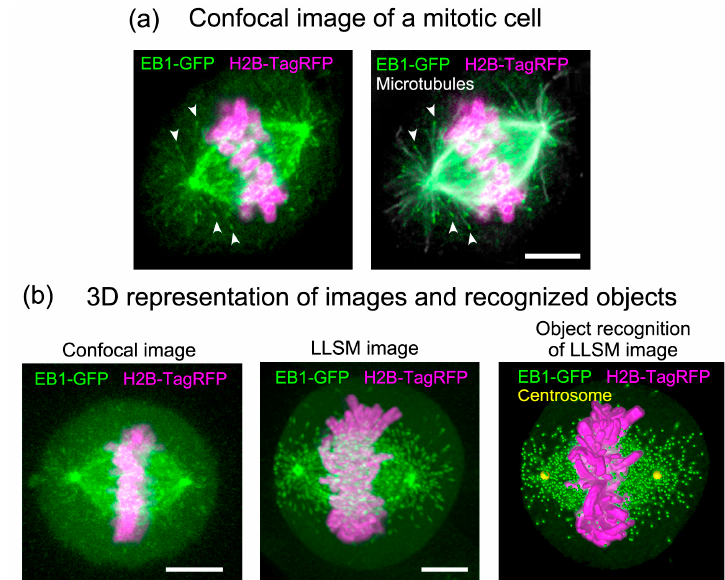
Figure 3. Comparison of 3D stack images collected by conventional confocal microscopy and LLSM.